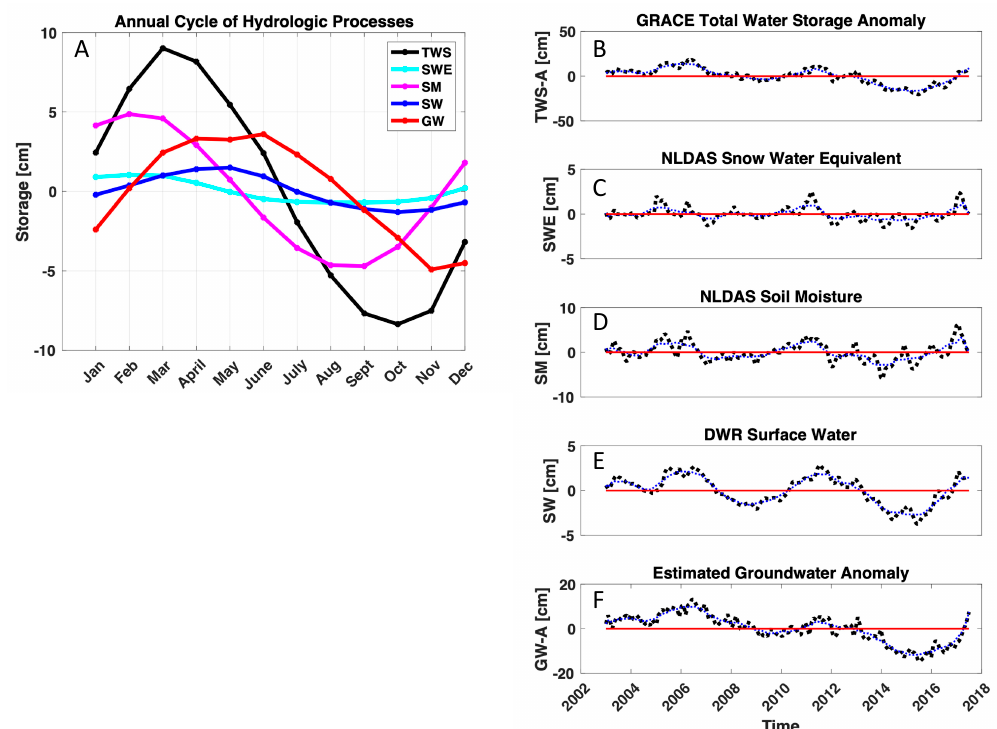
Figure 5. ( A ) The mean annual cycle for each process. The curves show the monthly averages. The cascading effect of the water cycle is clearly depicted in these figures. ( B − F ) Individual month deviations from the mean annual cycle (black dots), which shows each water process normalized by its interannual variability. A 13-month running mean (blue dots) show the state of each water process relative to its climatology for that month. This allows us to investigate the beginning, the peak, and the ending of each drought period.